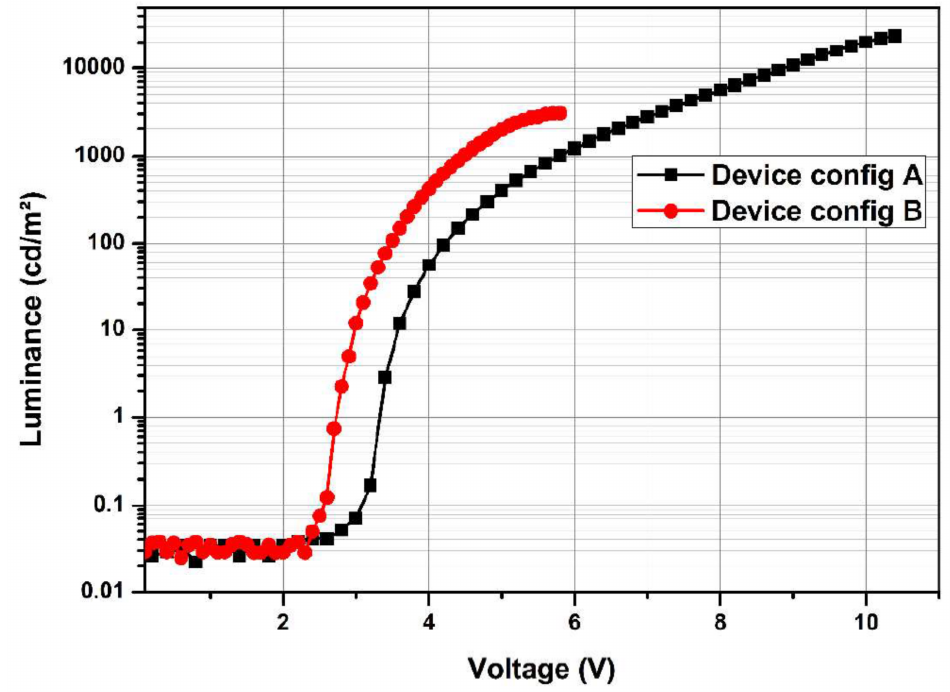
Figure 3. Luminance–voltage characteristics obtained with the two device configurations (A and